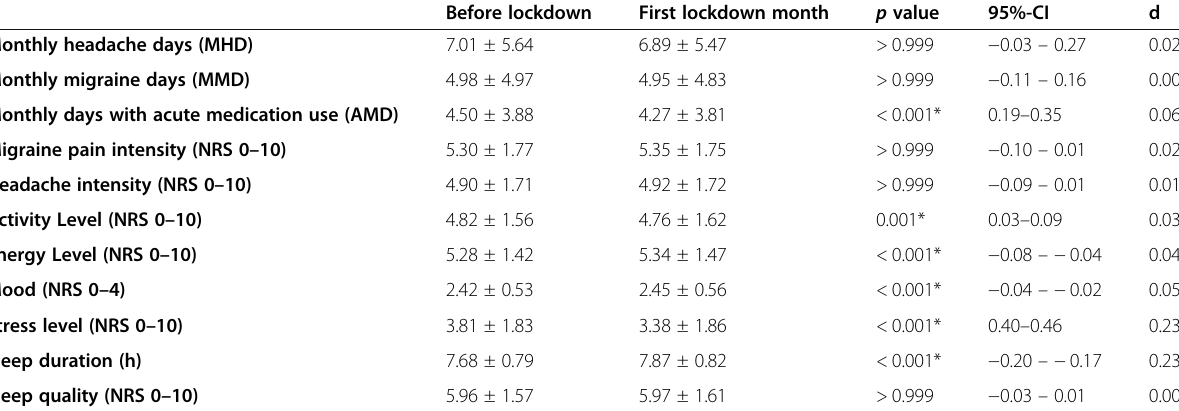
Table 1 Headache characteristics and potential trigger factors during the 28-day period before and the first 28 days of the lockdown period in Germany